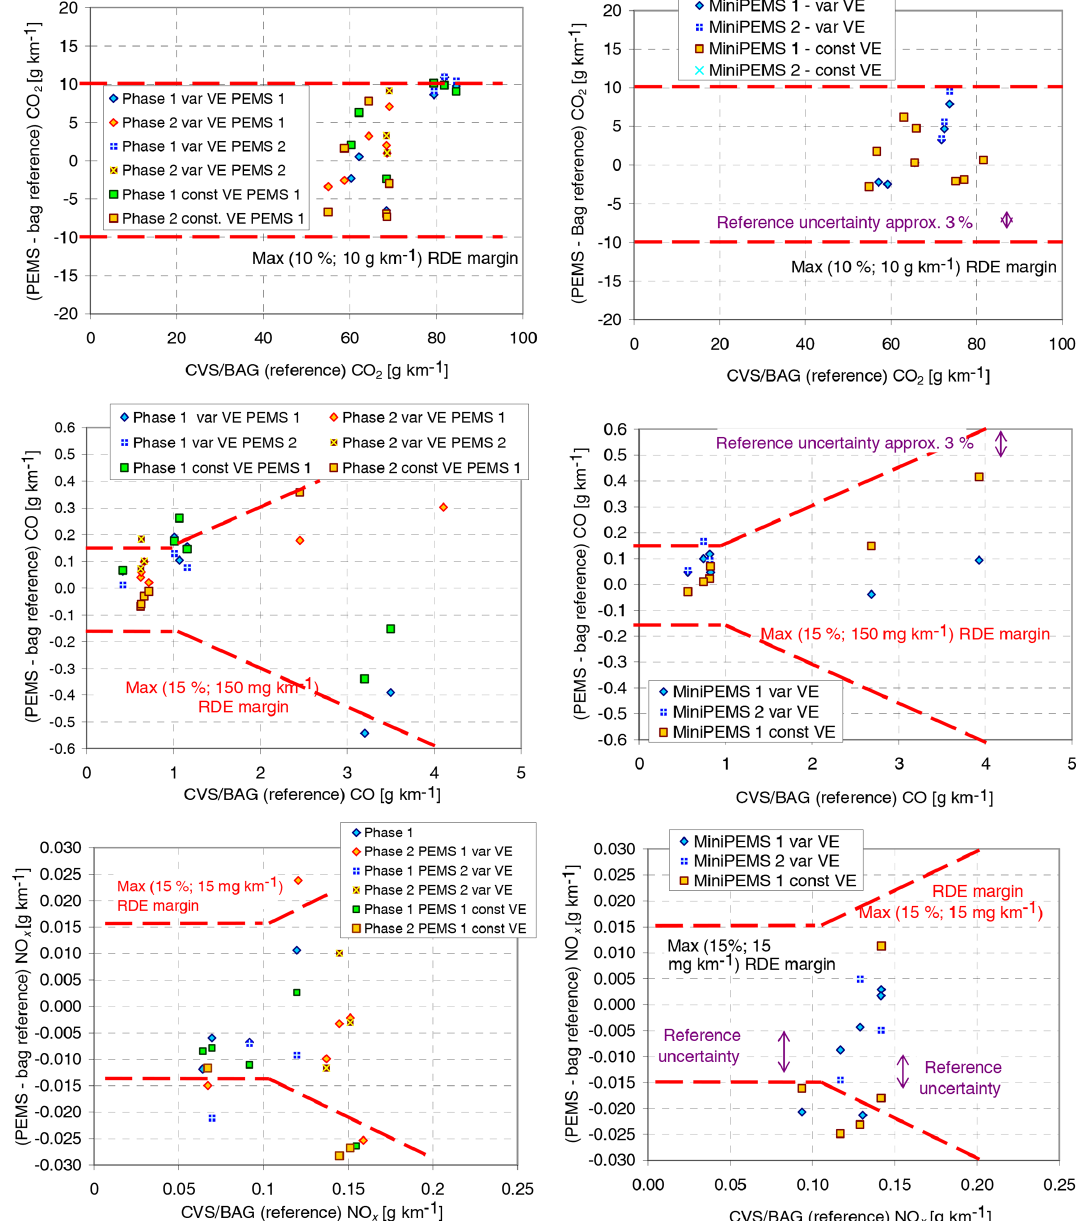
Figure 6. Relative deviations (%) between PEMS and laboratory emission factors during roller bench tests. Red dashed lines represent the PEMS validation tolerances as per Regulation EU 2018/1832 (EC, 2018a); see text for